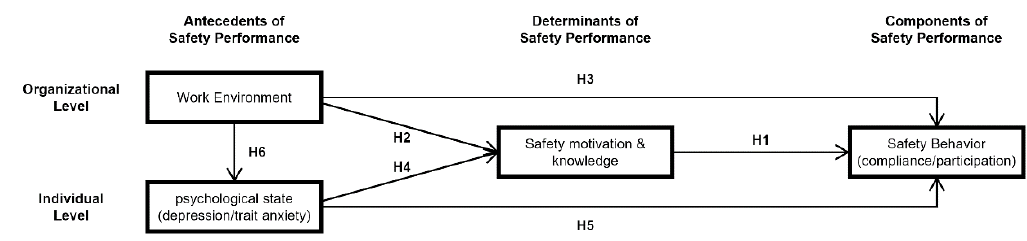
Figure 1. Conceptual research model.